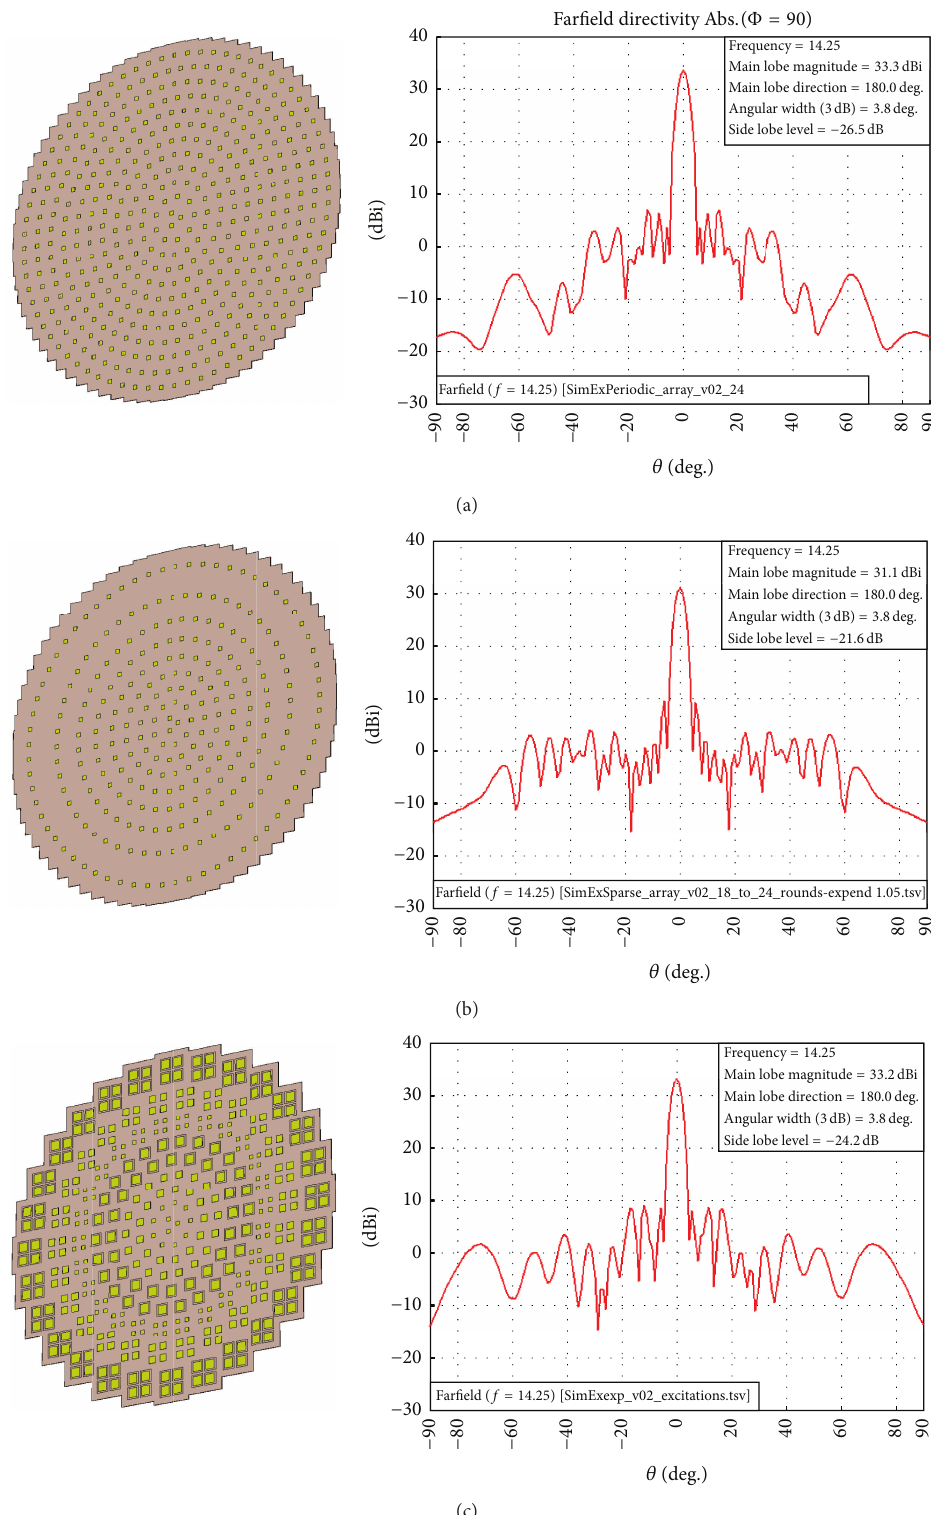
Figure 9: Simulation model and results of three arrays: (1) periodic annular array (upper), (2) conventional sparse array (middle), and (3) high efficiency sparse array